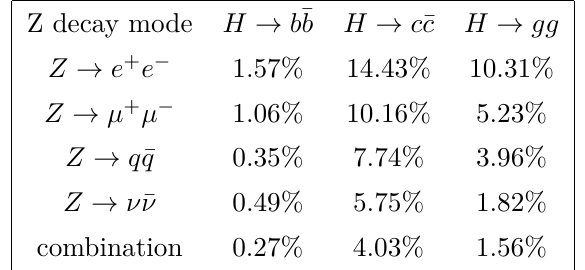
Table 3 . The signal strength accuracies for different